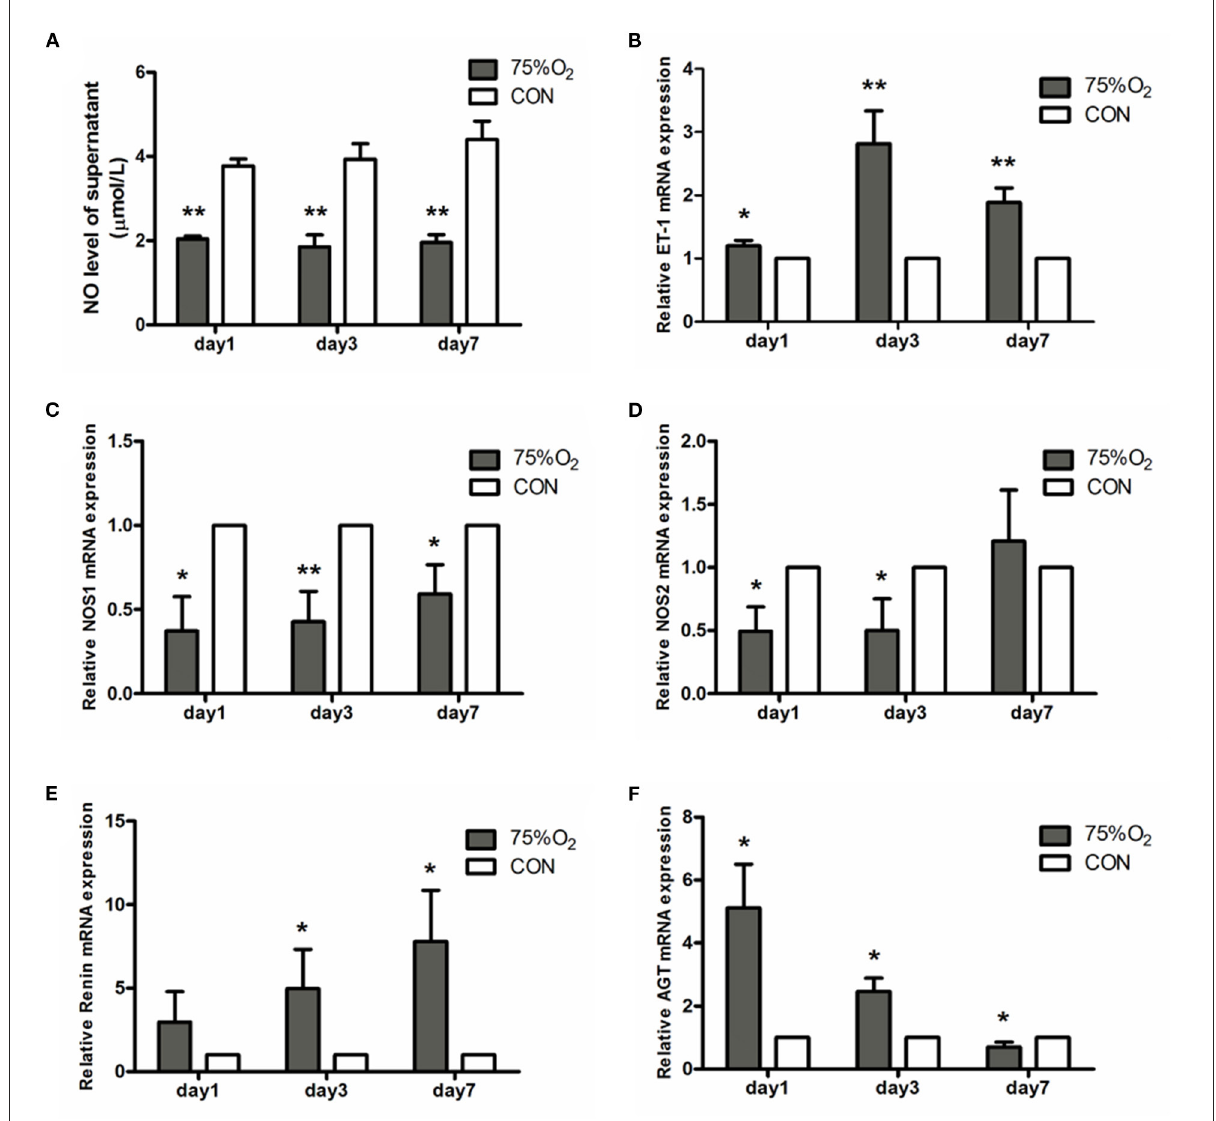
FIGURE9 NO levels of supernatant and relative mRNA expression of vasoactive substances in ONH astrocytes after hyperoxia culturing. (A) Hyperoxia inhibited NO production in astrocytes. The NO level of supernatant significantly decreased in 75%O 2 on days 1, 3, and 7. (B) Real-time PCR showed that the genetic expression of ET-1 was obviously increased in hyperoxia. (C,D) Real-time PCR demonstrated that the genetic expression of NOS was obviously decreased in hyperoxia. (E,F) Real-time PCR showed that the genetic expression of RAS was obviously increased in hyperoxia. * p < 0.05, ** p < 0.01, NO, Nitric oxide; RAS, Renin-angiotensin